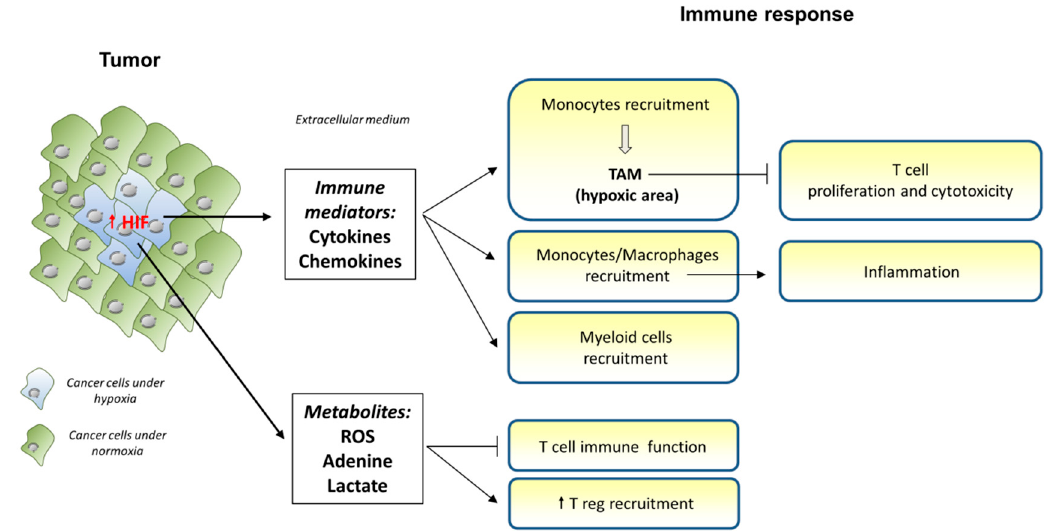
Figure 5. Consequences of hypoxia and HIF-1 production by cancer cells on the immune response. While proliferating, cancer cells develop hypoxic regions at the center of the tumor. This results in HIF-1 α stabilization and expression. HIF-1 α triggers the expression and release of several cytokines and chemokines that attract monocytes, macrophages and myeloid cells into these regions. In some cancers, monocytes differentiate into TAMs (tumor-associated macrophages) that impair T cell proliferation and cytotoxic properties. In other cases, recruited macrophages trigger inflammation, promoting cancer progression. Some myeloid cells like MDSCs contribute to immunosuppression. Finally, O 2 -deprived cancer cells may also produce and release metabolites such as ROS, adenine and lactate that will further block T cell function and increase the recruitment of Tregs with immunosuppressive functions.